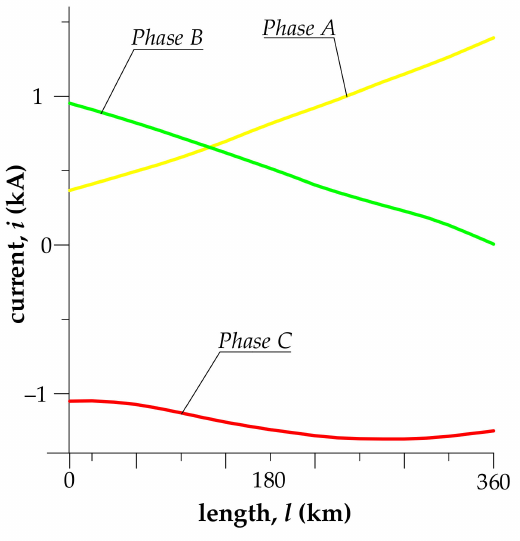
Figure 7. Space distribution of current changes across the line at t = 0.008